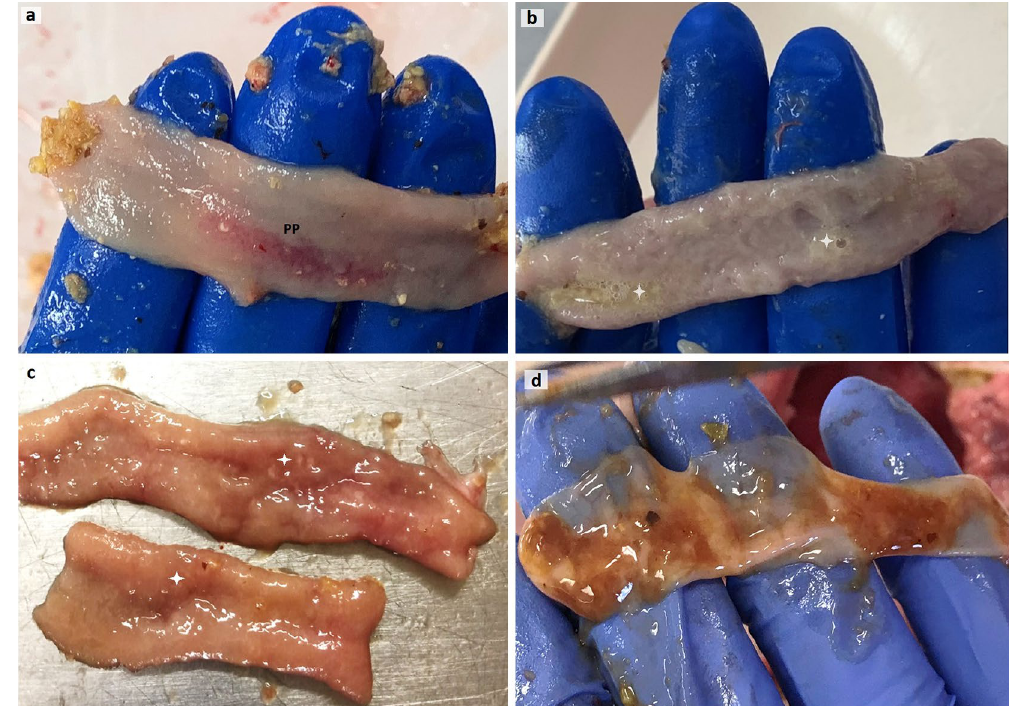
Figure 2. Gross pathology of the ileum from 21 d old chicks displaying mucosal changes characteristic for necrotic enteritis NE disease. Images of ileal mucosa from: a control chick showing normal mucosa and a hyperemic area representing Peyer’s patches ( a ); and from NE-challenged chickens: a watery content with moderate amount of gas ( b ), a creamy content covering hyperemic mucosa and some focal necrosis ( c ), thinning of intestinal wall, numerous necrotic foci and a bile-mixed content ( d ). PP is Peyer’s patches, white stars in ( b ) identify gas presence, and in ( c ) necrotic